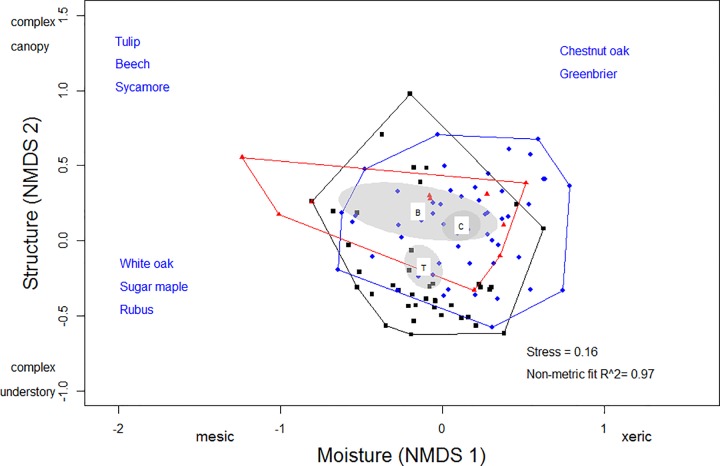
Charcaterization of habitat space in the unaltered, burned and harvested habitat.Results of a nonmetric multidimensional scaling analysis of similarity in the vegetational composition and structure in random habitat plots, nest habitat plots and male territory habitat plots from the unaltered (circles), selective harvest (squares) and the burn habitat (triangles). Convex hulls are plotted for each stand and 95% confidence ellipses based on the standard deviation of the weighted distance from the group centroid are indicated (C = unaltered habitat, B = burned habitat, T = selective harvest habitat).